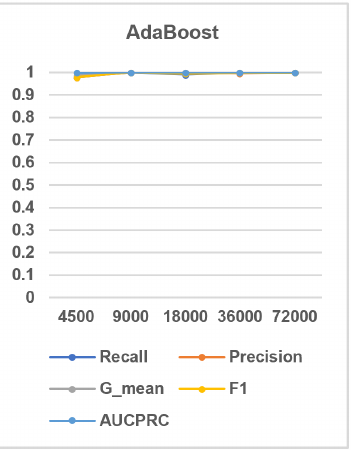
Figure 19. MetaCost: Impact of Dataset Size